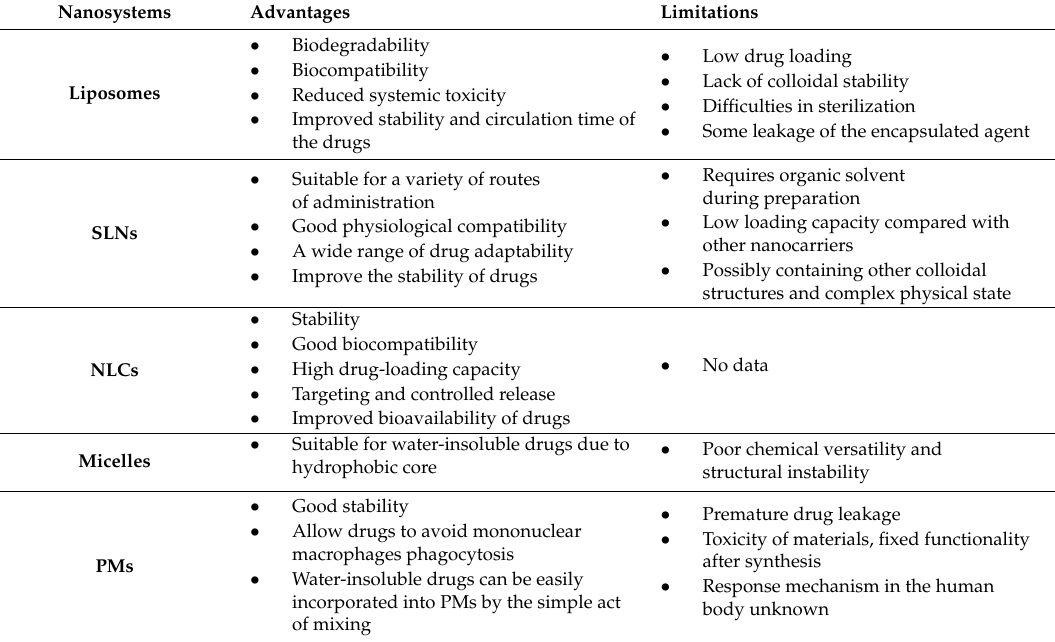
Figure 2. Schematic representation of the commonly used nanocarrier types: Liposome, solid lipid nanoparticle (SLN), nanostructured lipid carrier (NLC), polymeric micelles (PMs), nanocapsule, nanosphere, metal nanoparticle, quantum dot (QD), mesoporous silica nanoparticle (MSN), polymer–lipid hybrid nanoparticle (PLN), metal–organic framework (MOF), micelle, selenium nanoparticle (SeNP), magnetic nanoparticle (MNP), nanoemulsion, nanocrystal, nanodiamond (ND), dendrimer, niosome, and viral nanoparticle. Table 1. Summary of types of NPs and their advantages and limitations.